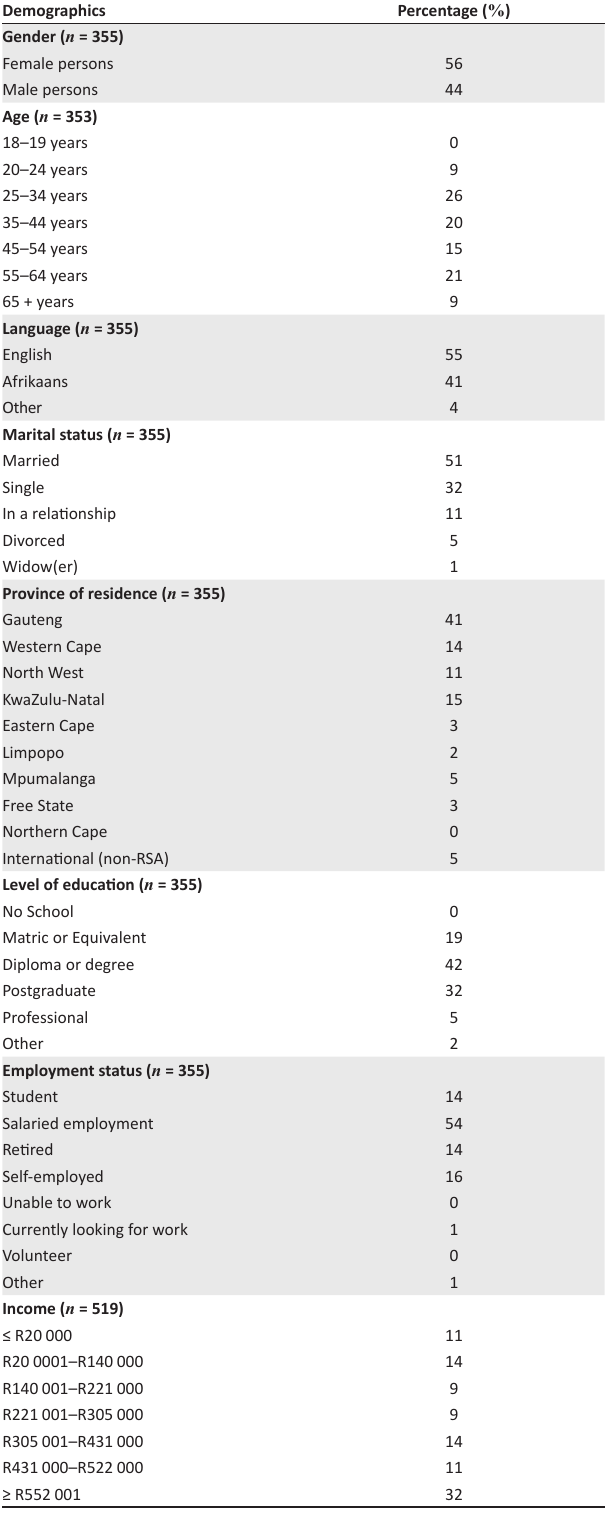
TABLE 2: Sociodemographic information of the 356 participants.